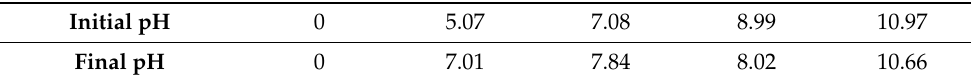
Table 2. Experimental results of pH based on drift method.